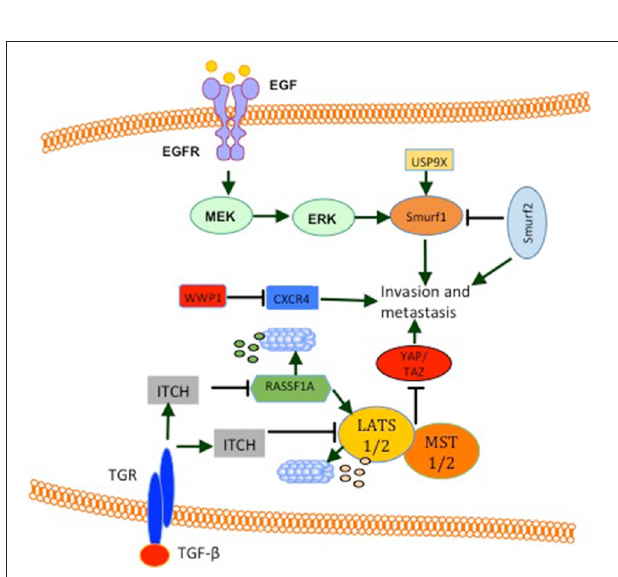
FIGURE 6 | E3 ligases regulate breast cancer cell proliferation. In breast cancer, both, WWP1 and SMURF1 stabilize ER and enhances its activation. WWP1 can also ubiquitinate and degrade LATS1 and liberates YAP/TAZ transcriptional activities. In contrast to this WWP1 can also target the pro-proliferative factor KLF5 and inhibit cell growth. This WWP1 activity can be inhibited by YAP and TAZ. SMURF2 supports cell proliferation by activating the PI3K-A-AKT-FoxO3 pathway. ITCH with angiomotin lead to YAP degradation and inhibits YAP proliferative activities. Wnt signaling inhibits WBP2 degradation by ITCH, and increases its transcription transactivation function. All these are mechanisms that activate cell cycle and transcription of pro-proliferative